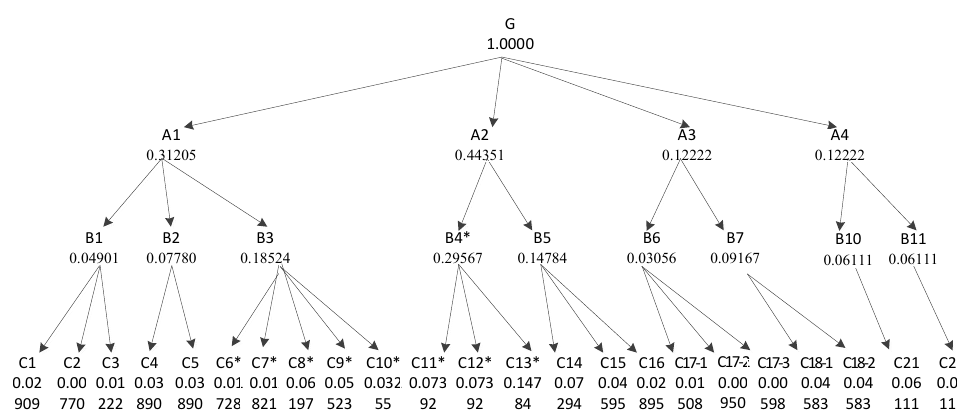
Figure 3. Index weight tree. The indicators marked with * refer to the adjusted indicators.